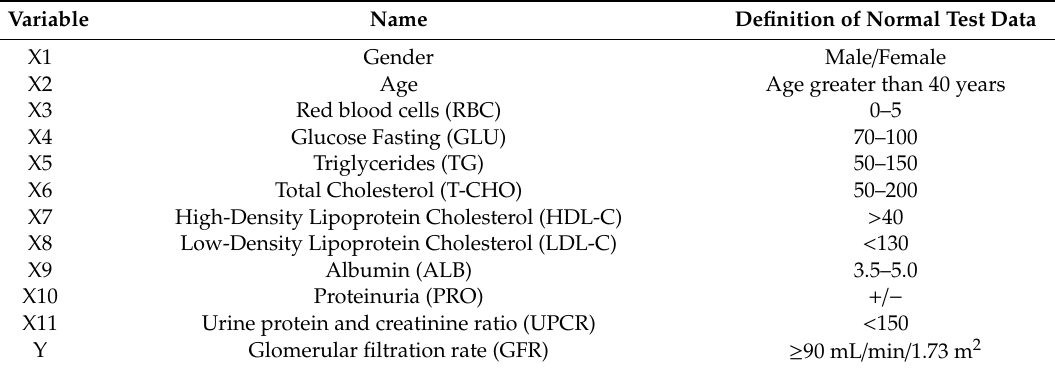
Table 2. Important variables and coding in this